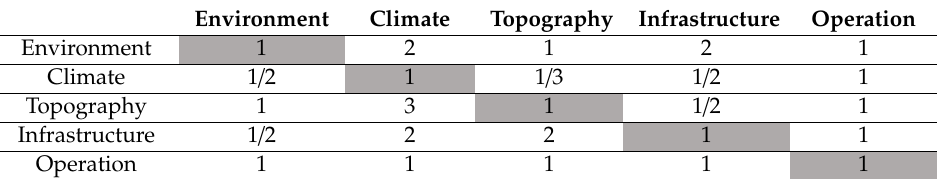
Table 5. Comparison matrix of the main